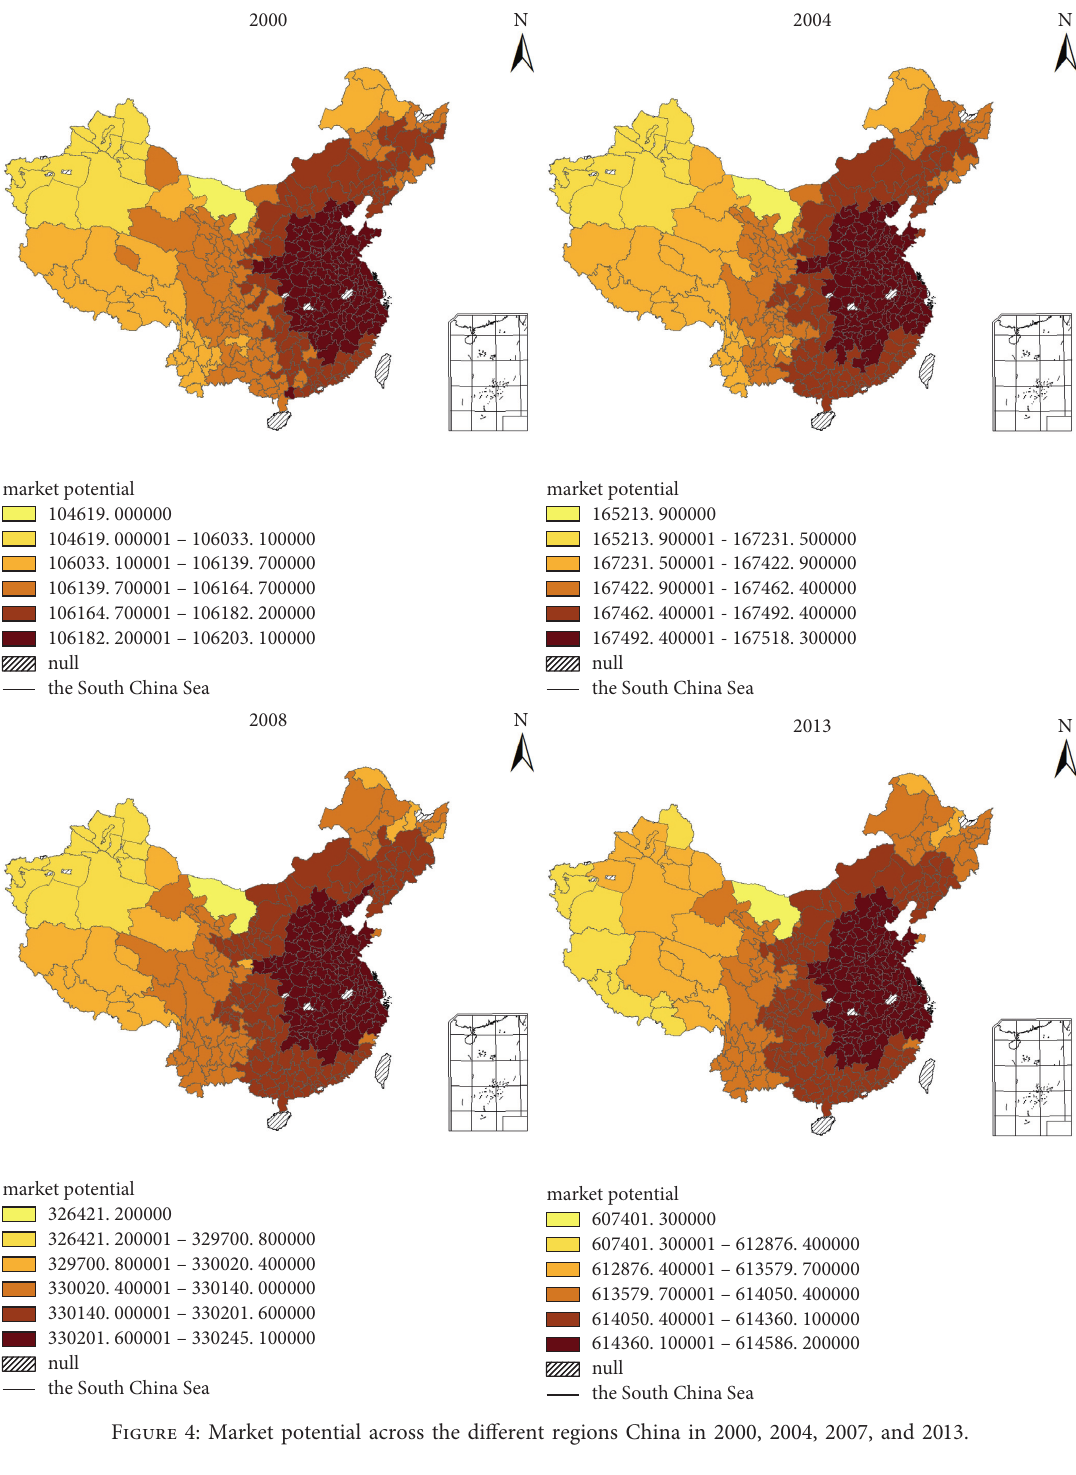
Figure 4: Market potential across the different regions China in 2000, 2004, 2007, and